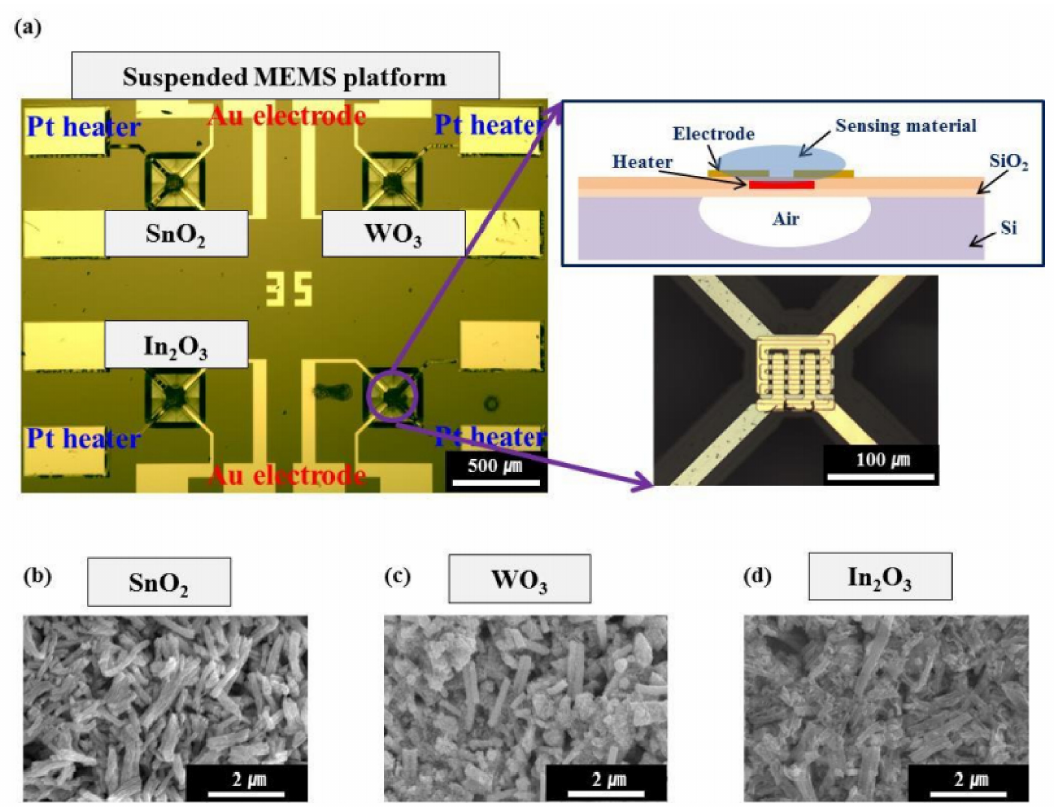
Figure 36. ( a ) MEMS gas sensor array fabricated by EHD printing of SnO 2 , WO 3 and In 2 O 3 nanofibers for low power consumption. The platform size is 3.5 × 3.5 mm. The configuration and SEM image of the individual element are also given here. ( b – d ) SEM images of nanofiber materials integrated on the suspended MEMS platform by EHD printing. Reprinted with permission from [372]. Copyright 2017 Elsevier.